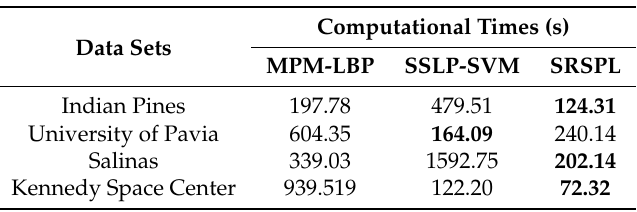
Table 4. Execution times of three semi-supervised methods of four data sets. (The bold values indicate the minimum computational times among the methods in each data